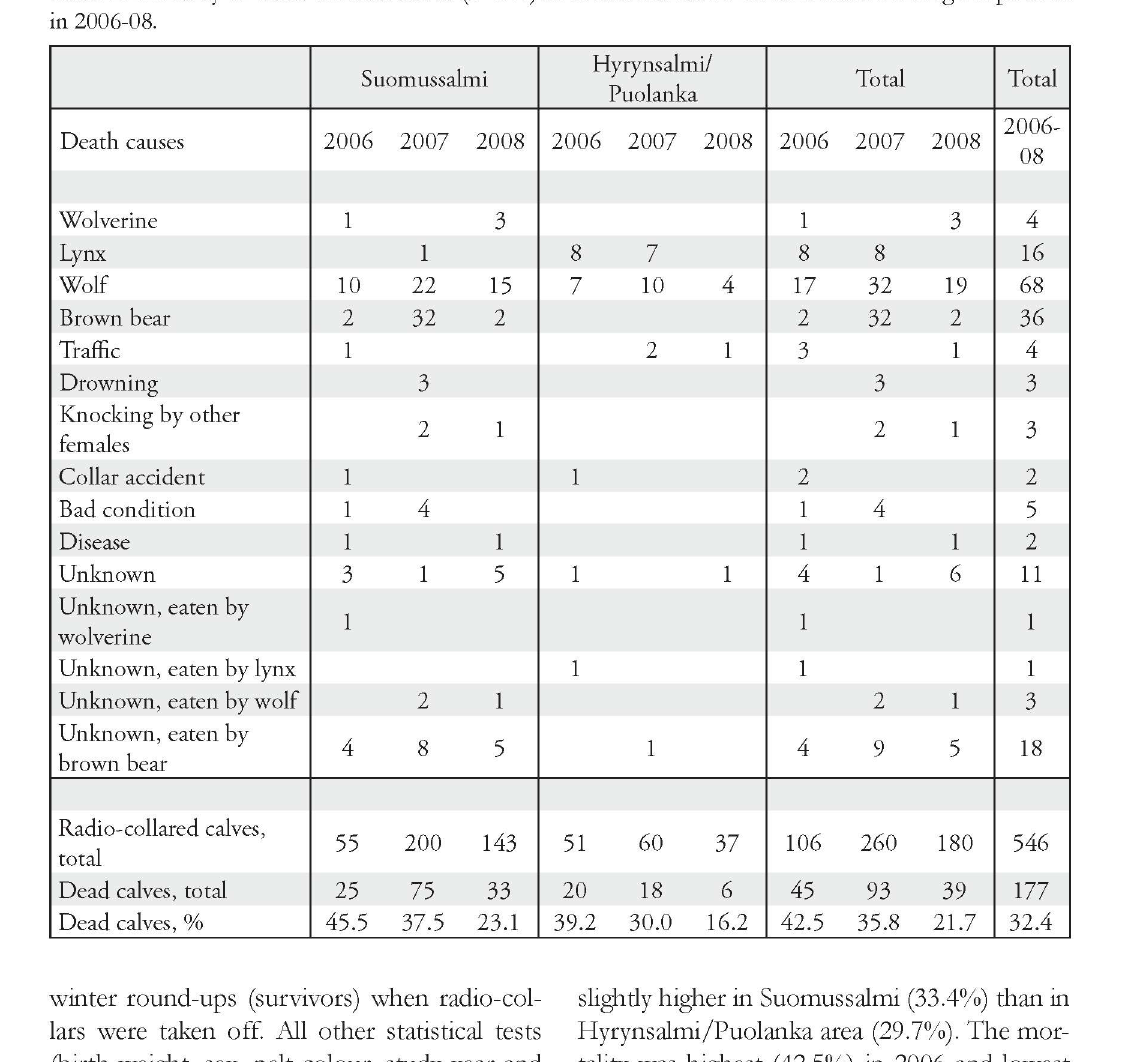
Table 1. Mortality of radio-collared calves (n=546) in different areas in Halla reindeer-herding cooperative in